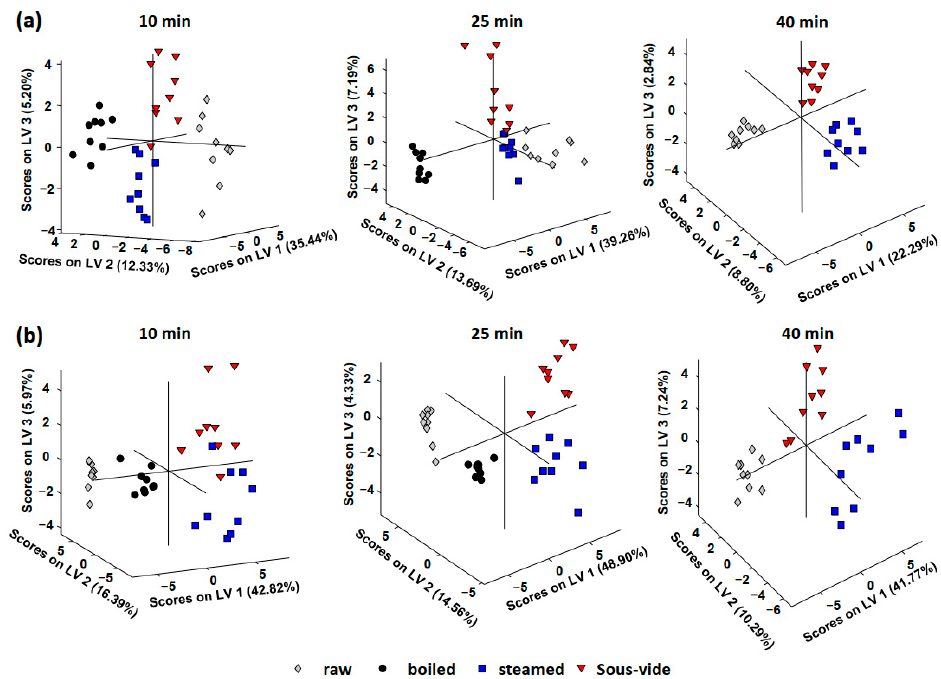
Figure 2. PLS-DA scores plots obtained using UHPLC–HRMS phytochemical profiles as chemical descriptors for the classification of ( a ) violet and ( b ) orange cauliflower samples according to the cooking procedure (raw samples, boiling, steamed, and sous-vide ).